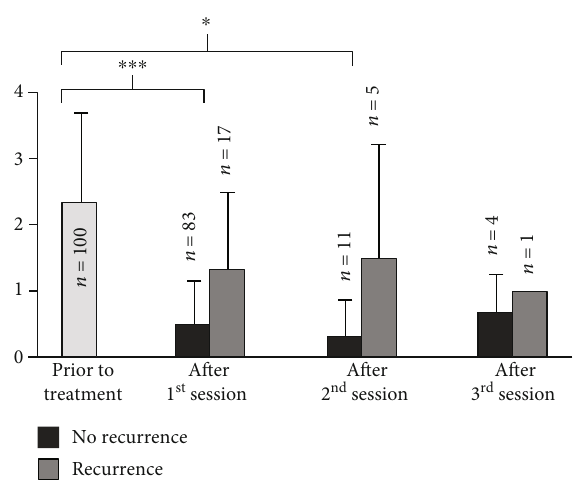
Figure 3: Dysphagia score of patients with and without recurrence after each session. Mean dysphagia score prior to initial treatment and six months after each session. Dysphagia score: 0: